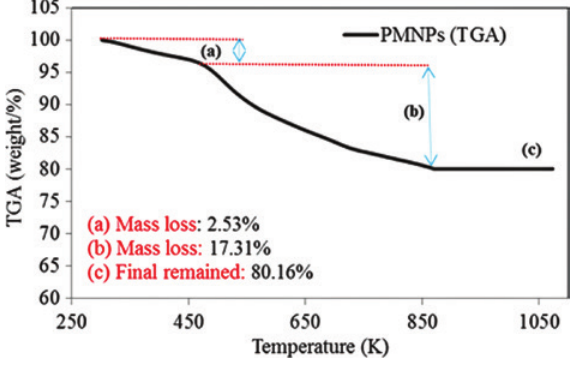
Figure 9: The M-H hysteresis loop/vibrating sample magnetometer (VSM) measurement of the phytogenic magnetic nanoparticles (PMNPs) at 300 K (the inset photo is the magnetic separation study of the PMNPs using a simple hand-held magnet; the distance between the magnet and the sample was 5 cm). Reproduced from Ali et al. (2018) with permission from Royal Society of Chemistry, UK.